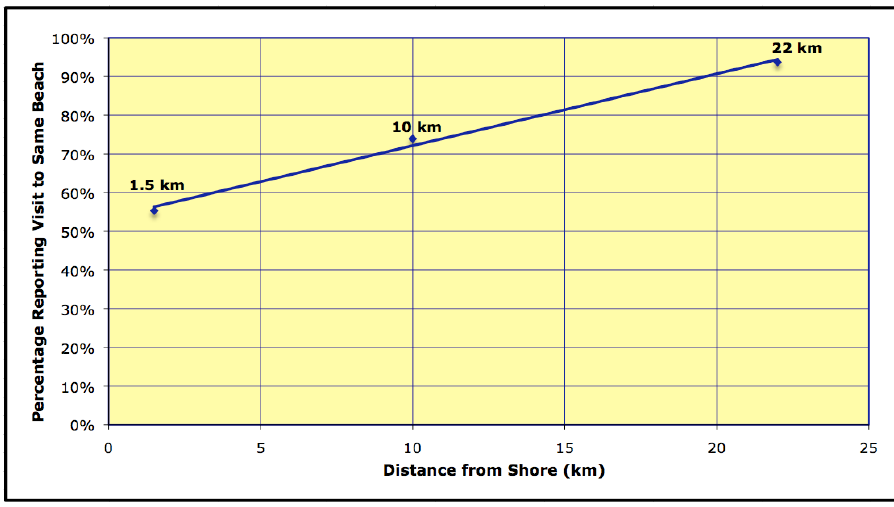
Figure 2. Acceptance of offshore wind in